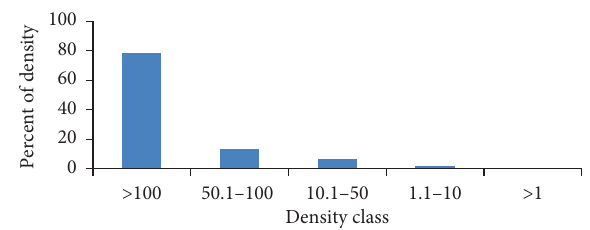
Figure 7: Percent of density with distribution of diferent classes.